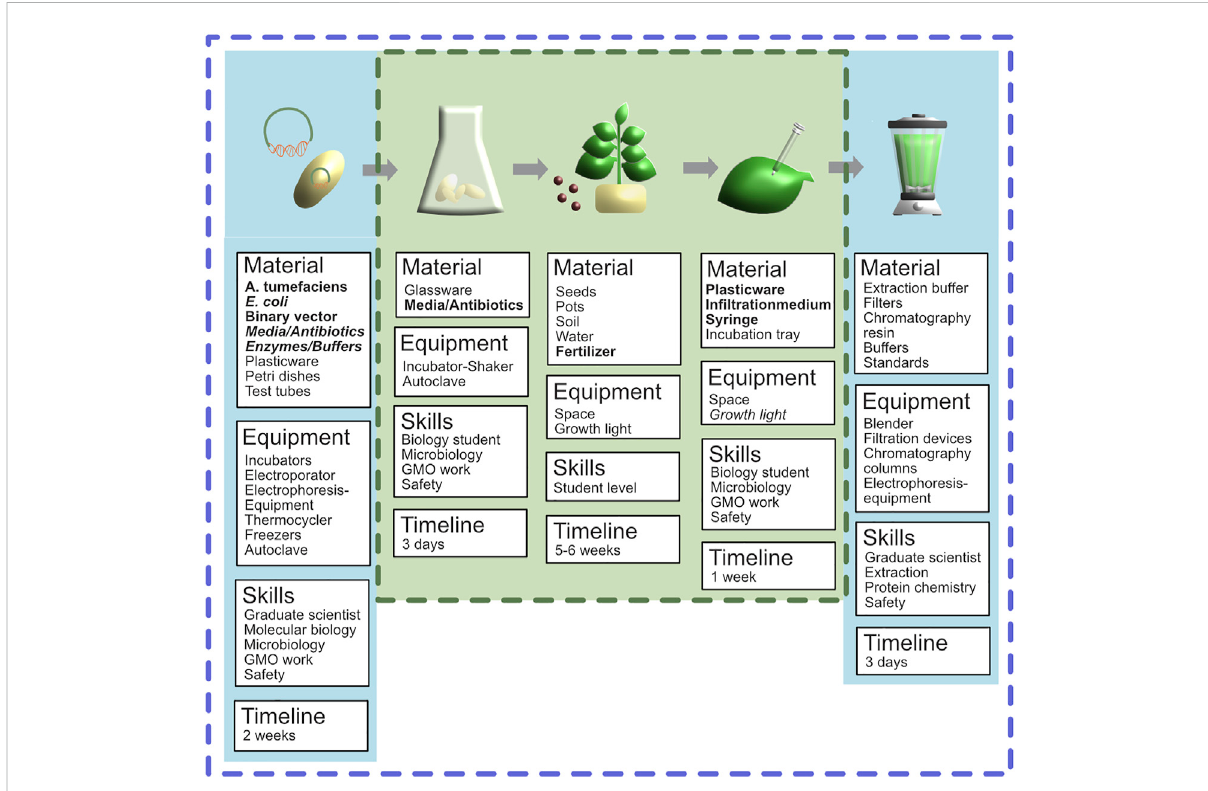
FIGURE 2 Illustration and listing of components associated with the different steps of ATT. Dark blue dashed line covers the procedure addressed by the R&D ATT kit. Dark green dashed line covers the core part of the procedure addressed by the educational ATT